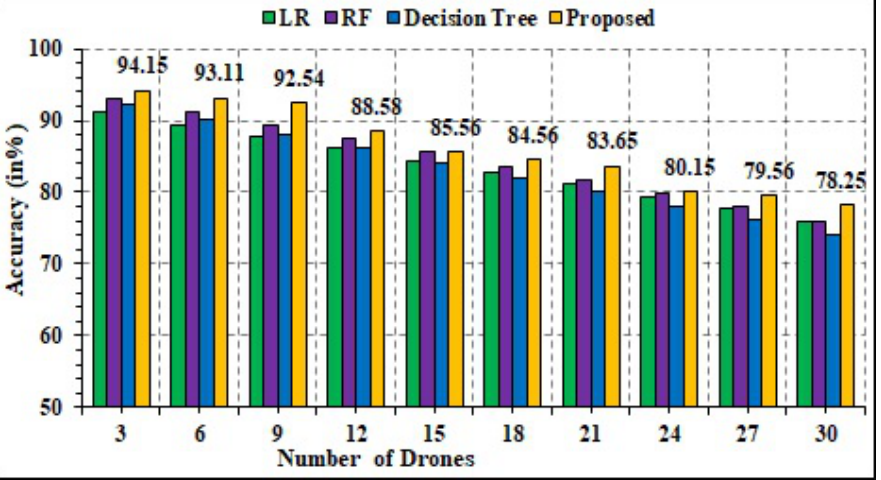
Figure 17. Accuracy